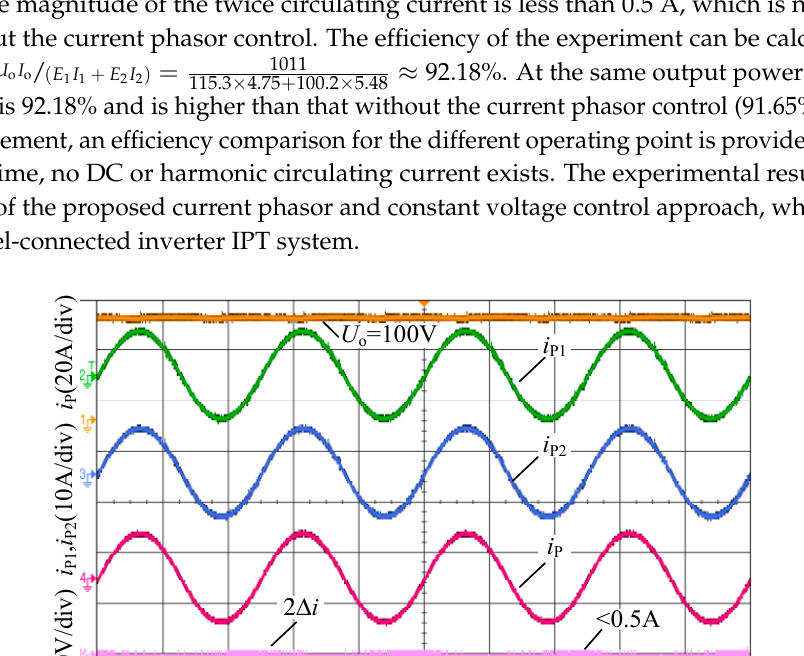
Figure 11. The waveforms of U o , i P1 , i P2 , i P and 2 i Energies 2017 , 10 , 261